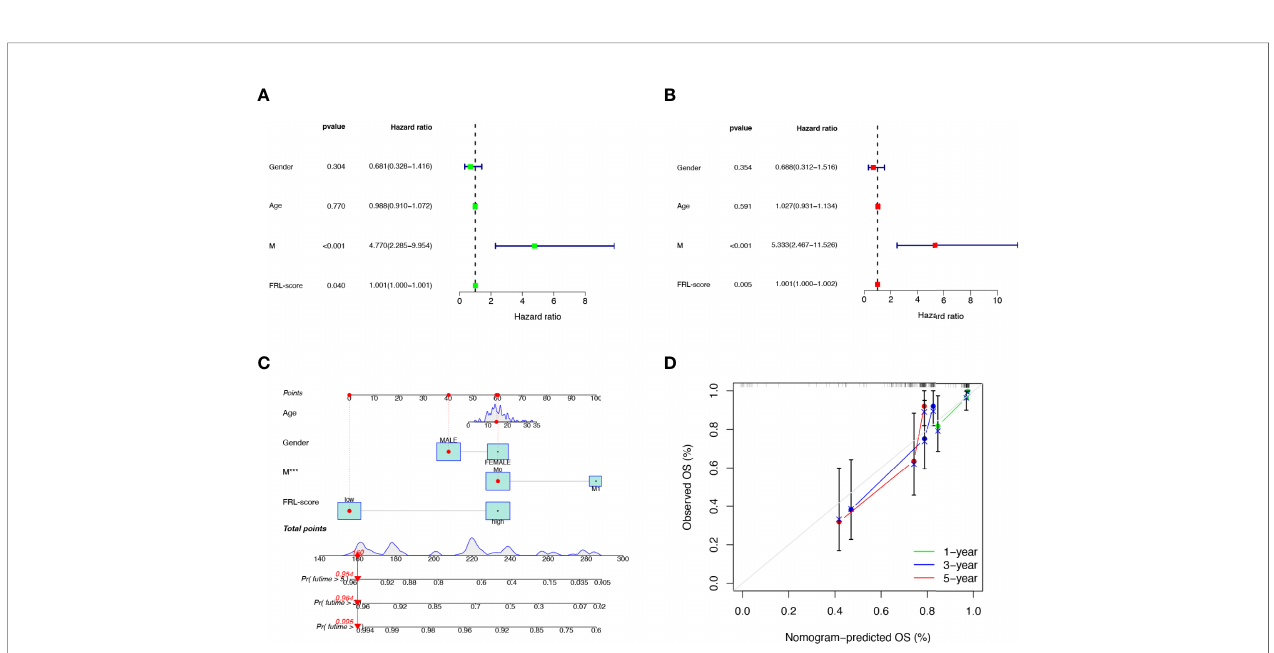
FIGURE 7 | Prognostic value of different clinical parameters and construction of nomogram. (A) Univariate analysis of various clinical parameters and FRL-score in osteosarcoma patients. (B) Multivariate analysis of various clinical parameters and FRL-score in osteosarcoma patients. (C) Nomogram constructed using different clinical parameters and FRL-score for predicting OS in osteosarcoma patients. (D) Calibration plot of the nomogram for predicting OS. OS, overall